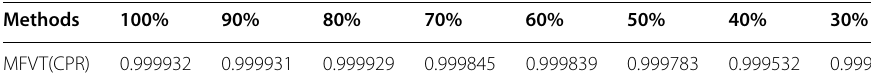
Table 6 Test results‑% of original training data Methods